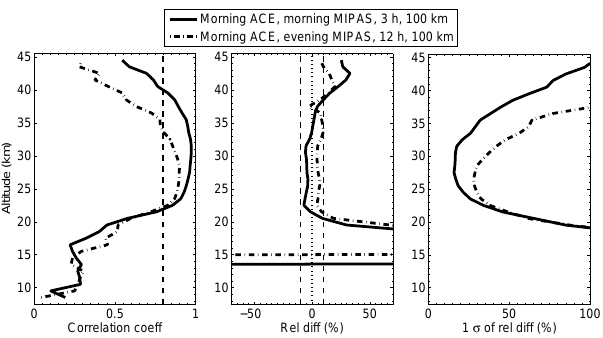
Figure 15. Weighted-average results for morning N 2 O 5 compar- isons between ACE-FTS and MIPAS (ESA and IMK-IAA) mea- surements with coincidence criteria of within 3h and 100km (solid) and comparisons between diurnally scaled morning ACE-FTS and evening MIPAS measurements with coincidence criteria of within 12h and 100km (dot-dash).